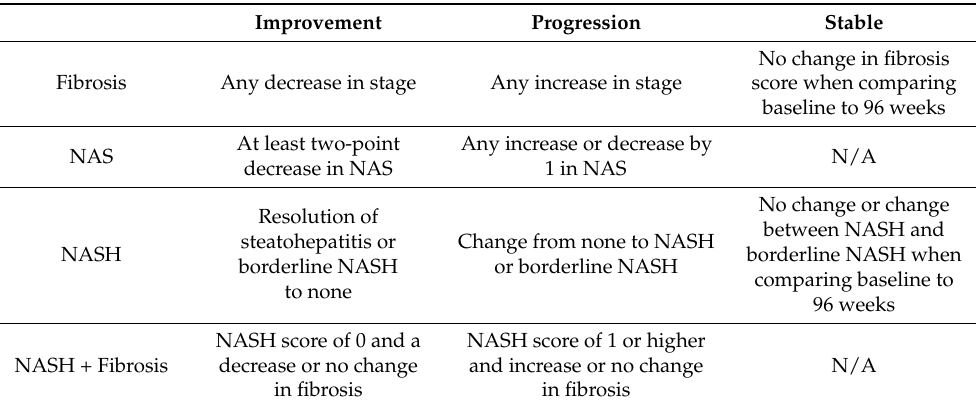
Table 1. Histologic assessment